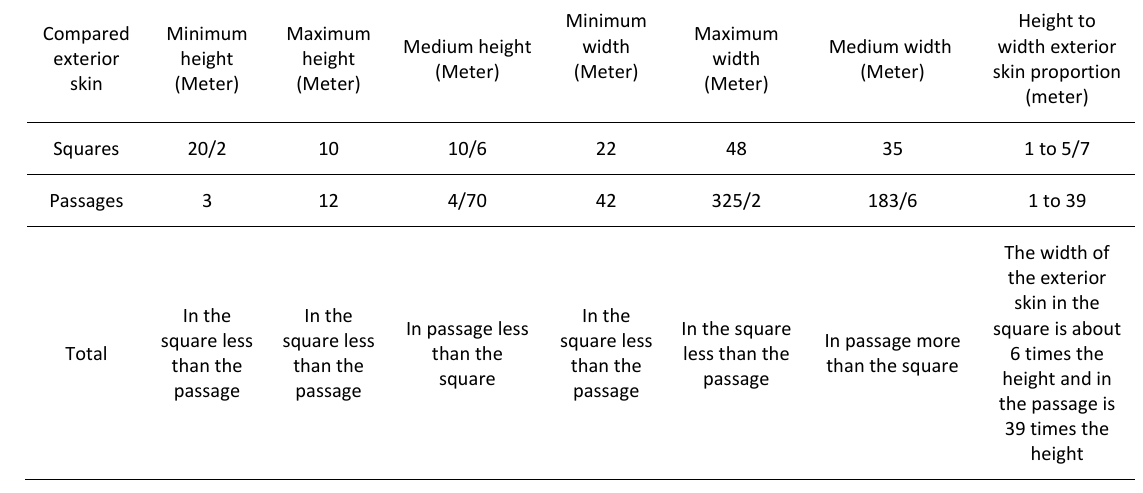
Table 6: Comparison of the proportions governing the squares and passages exterior skin of Yazd district